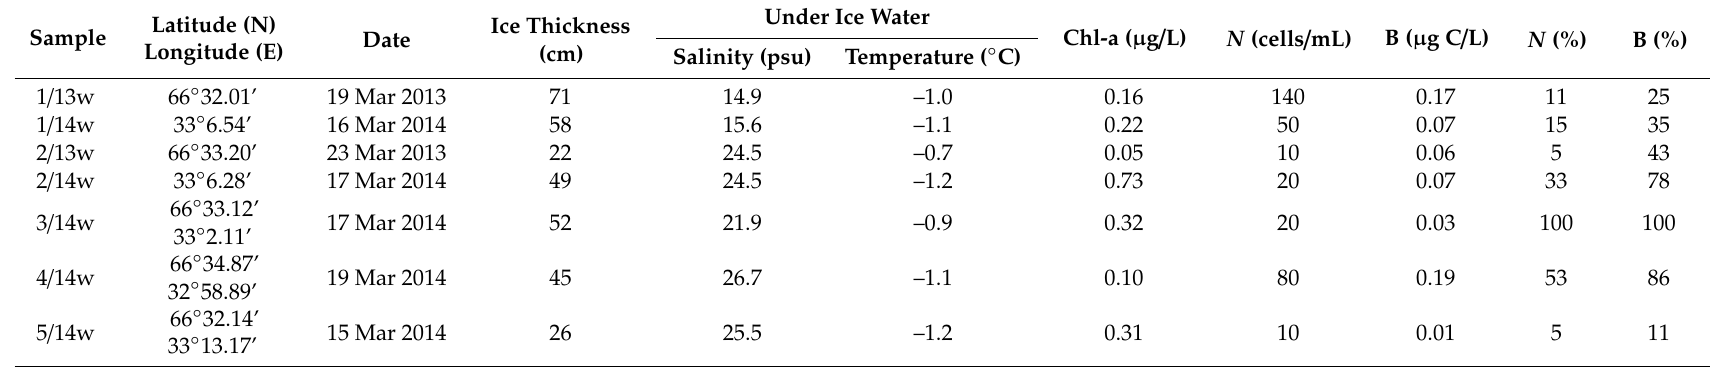
Table 1. Characteristics of under-ice waters at the sampling stations of the White Sea: total chlorophyll a concentration, the abundance (N) and biomass (B) of photosynthetic picoeukaryotes, and their contribution to total picophytoplankton (including cyanobacteria) abundance ( N , %) and biomass (B,